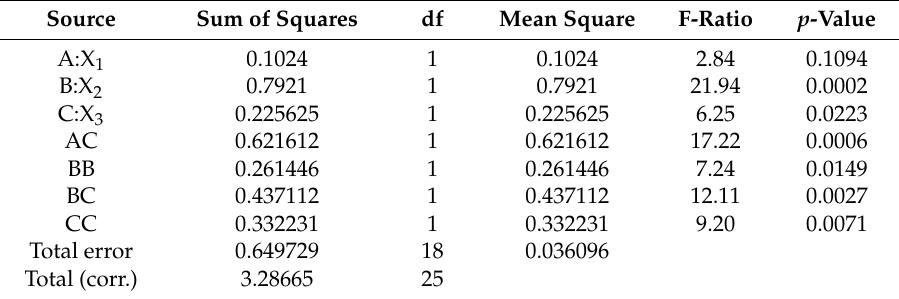
Table 2. ANOVA for pine sawdust biocatalyst.